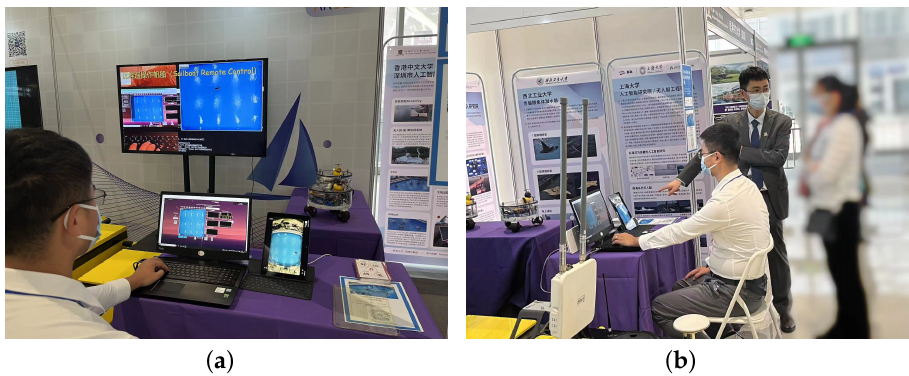
Figure 6. Remote control from the exhibition hall of China National Computer Congress 2021. ( a ) STAr’s control interface display and remote control demonstration. ( b ) Visitors watch the remote control process and experience the control of a real sailing